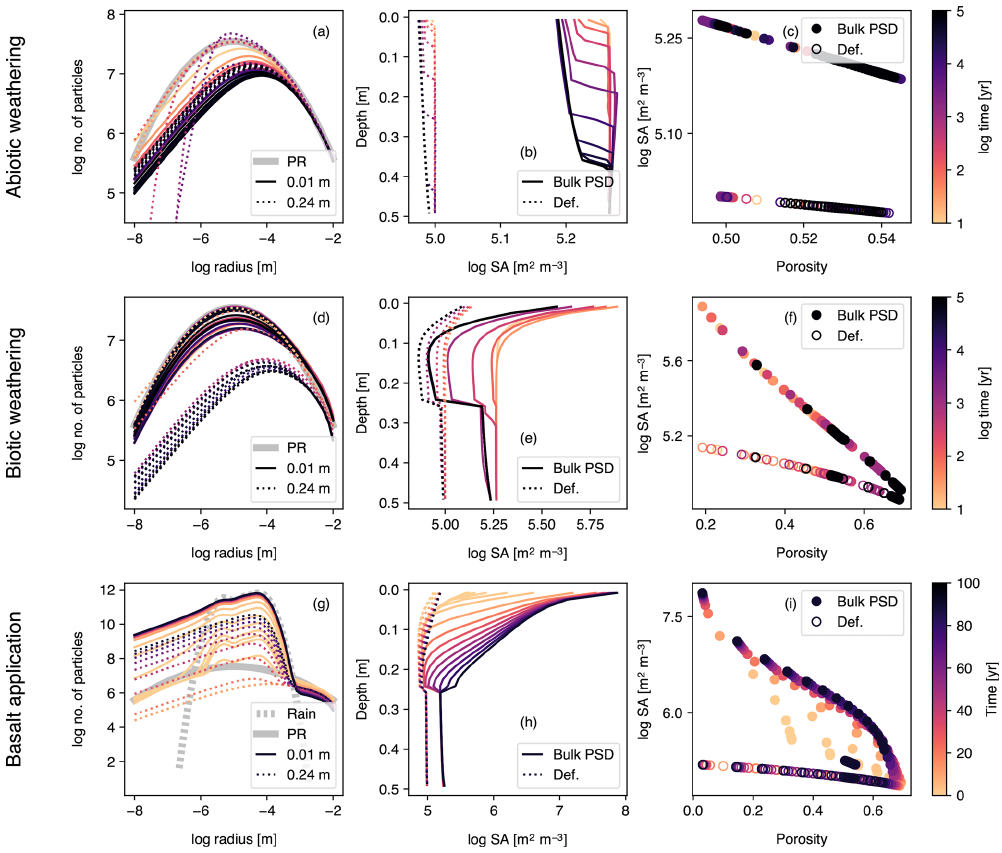
Figure 10. Simulations of abiotic weathering (a–c) , biotic weathering (d–f) and basalt powder application (g–i) at Site 1 in Table 8 with surface area calculated based on tracked particle size distribution (PSD) for bulk soil. PSDs at surface and bottom of soil mixed layer are shown in (a) , (d) and (g) . Pore surface area per unit pore volume is plotted against depth (b, e, h) or porosity (c, f, i) and compared with the calculation with the default surface area parameterization. See Sect. 3.1.4 and Table 7 for the details on the boundary conditions of the